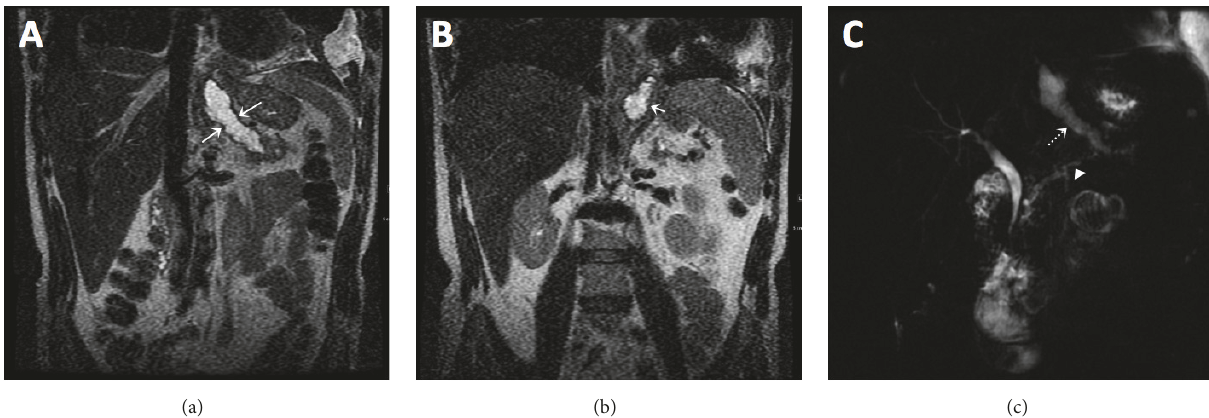
Figure 3: Coronal T2-weighted MRCP images (a, b) demonstrate a hyperintense tract arising from the tail of pancreas ((a) large white arrows), crossing the diaphragm and entering the pleural space ((b) short white arrow). Thick slab 2D MRCP images (c) show an irregular main pancreatic duct (white arrow head) and redemonstrates the fistula tract arising from the tail of pancreas (white dashed arrow).